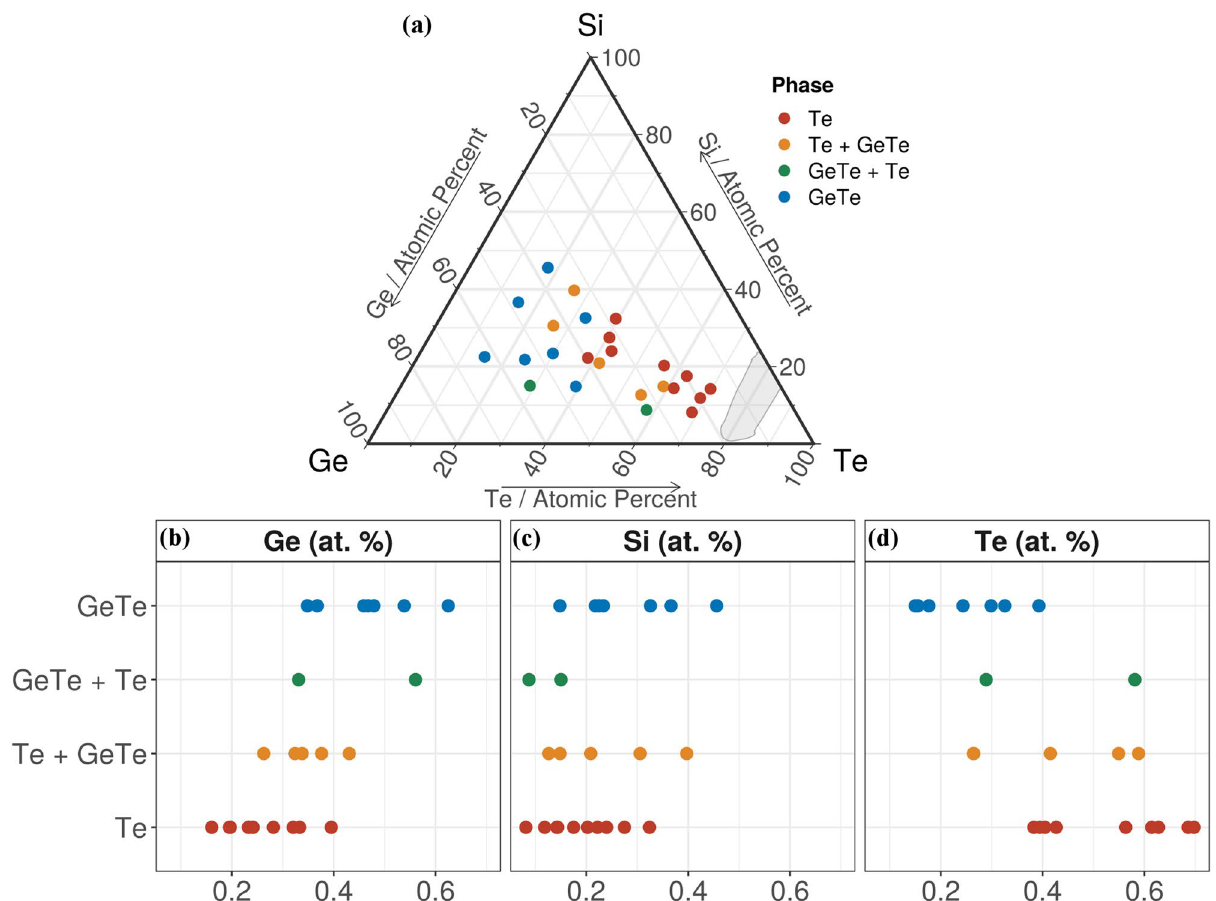
Figure 8. Crystalline phases formed after annealing the combinatorial library at 400 °C. Crystalline phases shown as a function of ( a ) composition in the Si–Ge–Te ternary diagram; and elemental concentration of: ( b ) Ge; ( c ) Si and ( d ) Te. The ternary diagram in ( a ) was generated with the R software [v. 3.6.3] (R: A language and environment for statistical computing, R Core Team, R Foundation for Statistical Computing, Vienna, Austria (2020) http:// www.R- proje ct. org/.) using the package ggtern [v. 3.3.0] (https:// cran.r- proje ct. org/ web/ packa ges/ ggtern/ index.